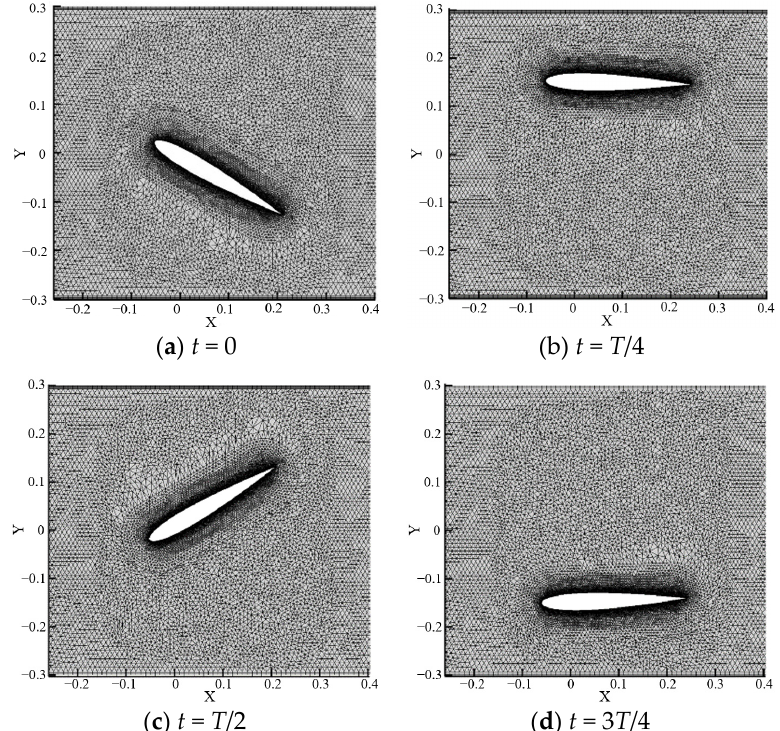
Figure 4. Dynamic mesh updating at four main points in a cycle.